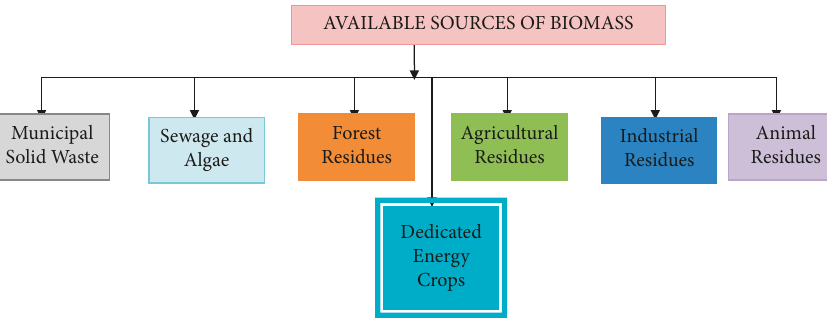
Figure 1: Various sources of biomass. Table 1: Comparative study on elemental analysis of biomass briquettes.